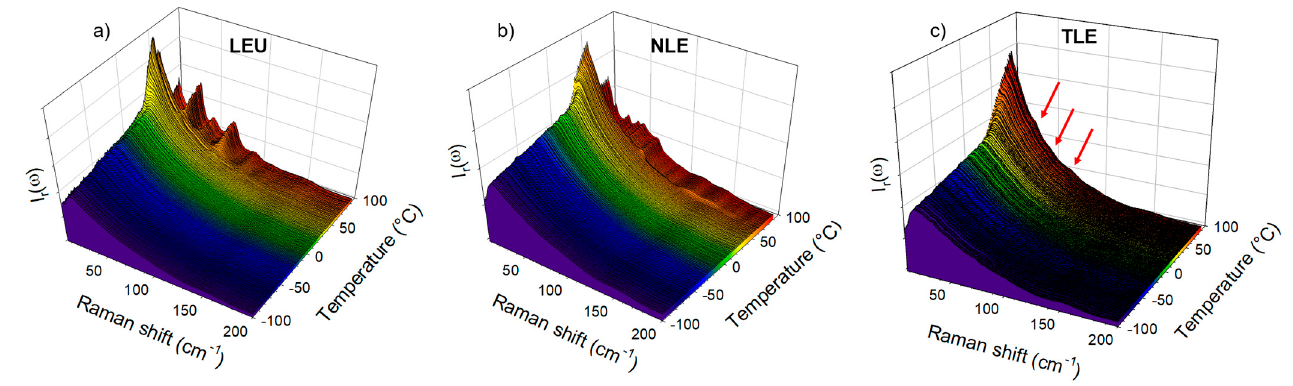
Figure 4. Temperature dependence of the low-frequency spectrum of the IMC–AA blends. Spectra were collected upon heating at 1 °C/min. ( a ) IMC–LEU; ( b ) IMC–NLE; ( c ) IMC–TLE.